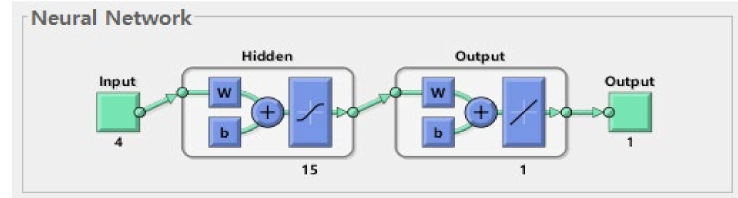
Figure 3. Structure of Neural Network.